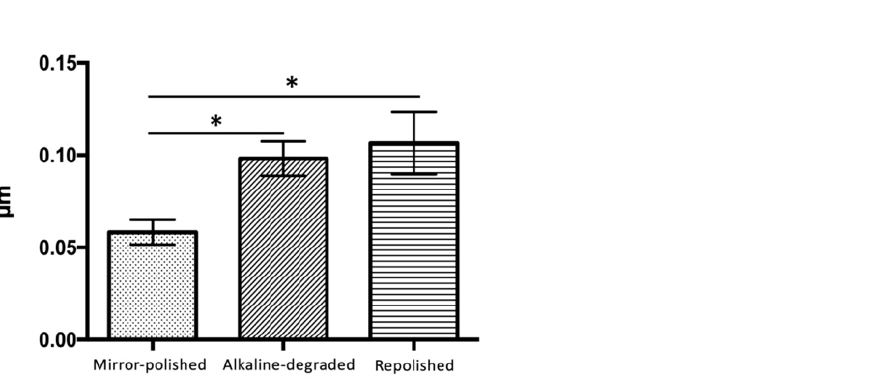
Figure 8. Line roughness. The bars (*) indicate the statistical difference (Bonferroni’s test, p < 0.001, n = 15).